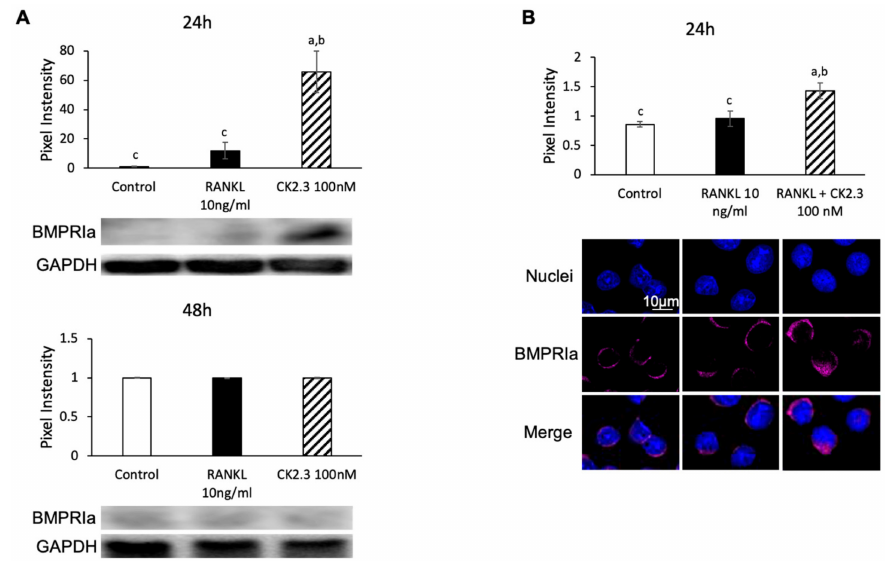
Figure 7. Regulation of BMPRIa expression by CK2.3. Expression of BMPRIa was upregulated in RAW264.7 cells after 24 h of CK2.3 stimulation, as determined by ( A ) Western blotting and ( B ) immunofluorescence. a: denotes significant di ff erence from Control, b: denotes significant di ff erence from RANKL at 10 ng / mL, and c: denotes significant di ff erence from RANKL + CK2.3 at 100 nM. 3.5. CK2.3 Did Not Mediate the Canonical SMAD Signaling Pathway of BMP2 Signaling Transduction in